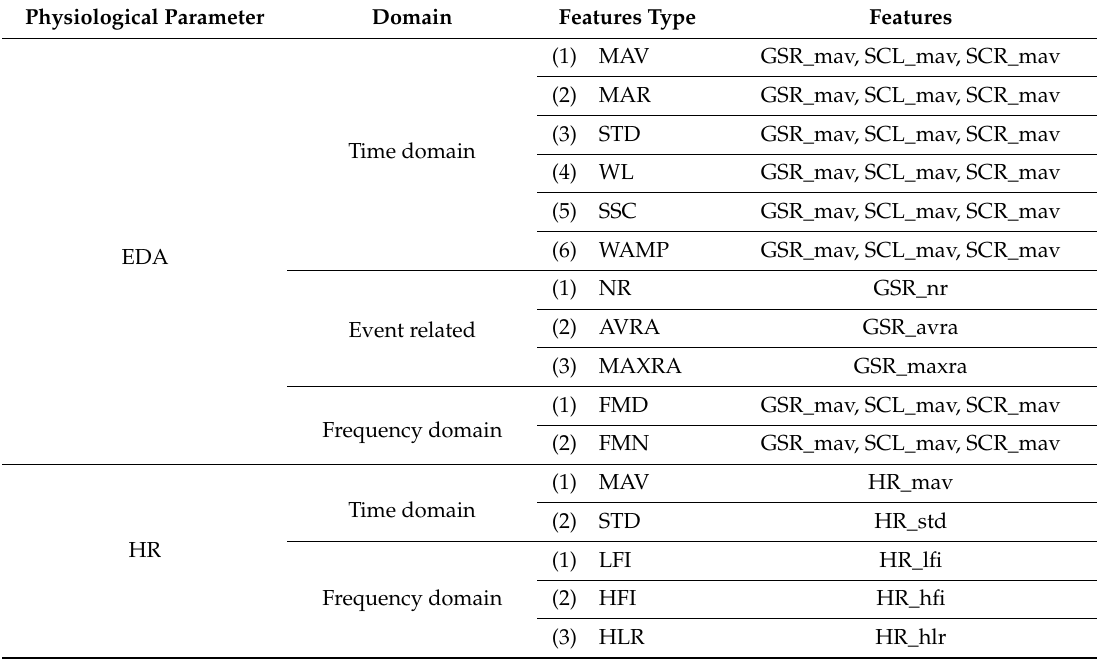
Table 1. Complete list of the 32 features extracted from the physiological signals.